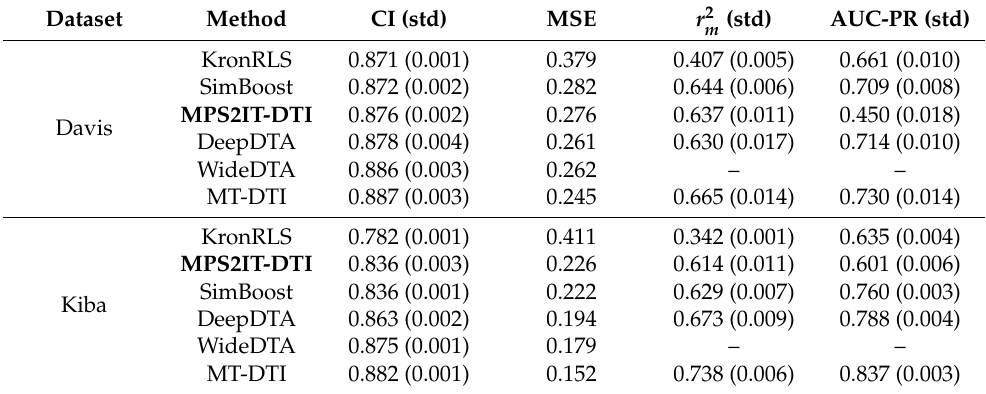
Table 4. Training and test results of the proposed MPS2IT-DTI model and other existing